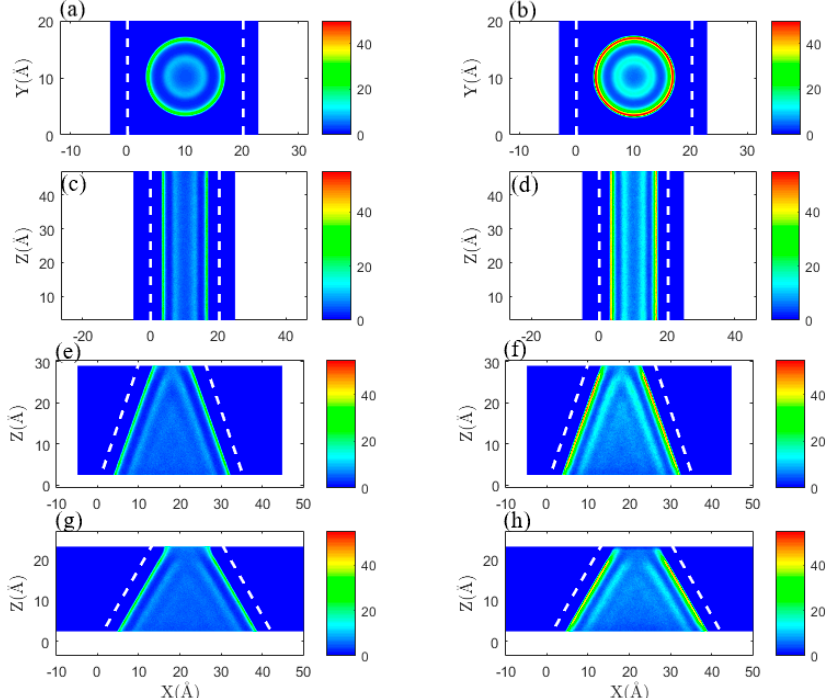
Figure 5. Density distribution of CH 4 (left) and CO 2 (right) in CNT/CNC. Top to bottom: CNT (15,15), XY plane; CNT (15,15), XZ plane; CNC (19.5°), XZ plane; CNC (30°), XZ plane. Mole fraction yCH 4 = yCO 2 = 0.5. T = 338 K, P = 20 MPa.